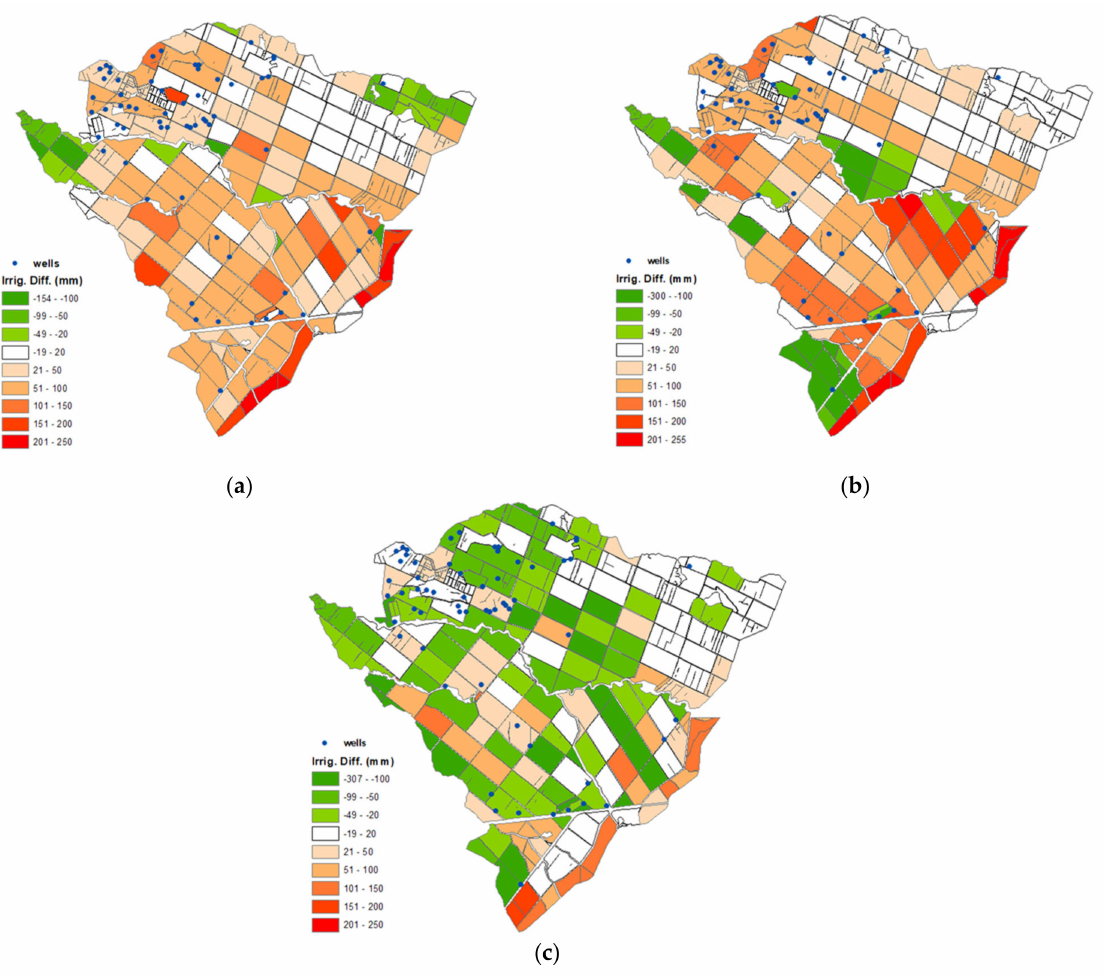
Figure 8. Map of differences between modeled irrigation requirements and observed irrigation water at field scale in the R3 irrigation district over the seasons 2002–2003 ( a ), 2005–2006 ( b ) and 2008–2009 ( c